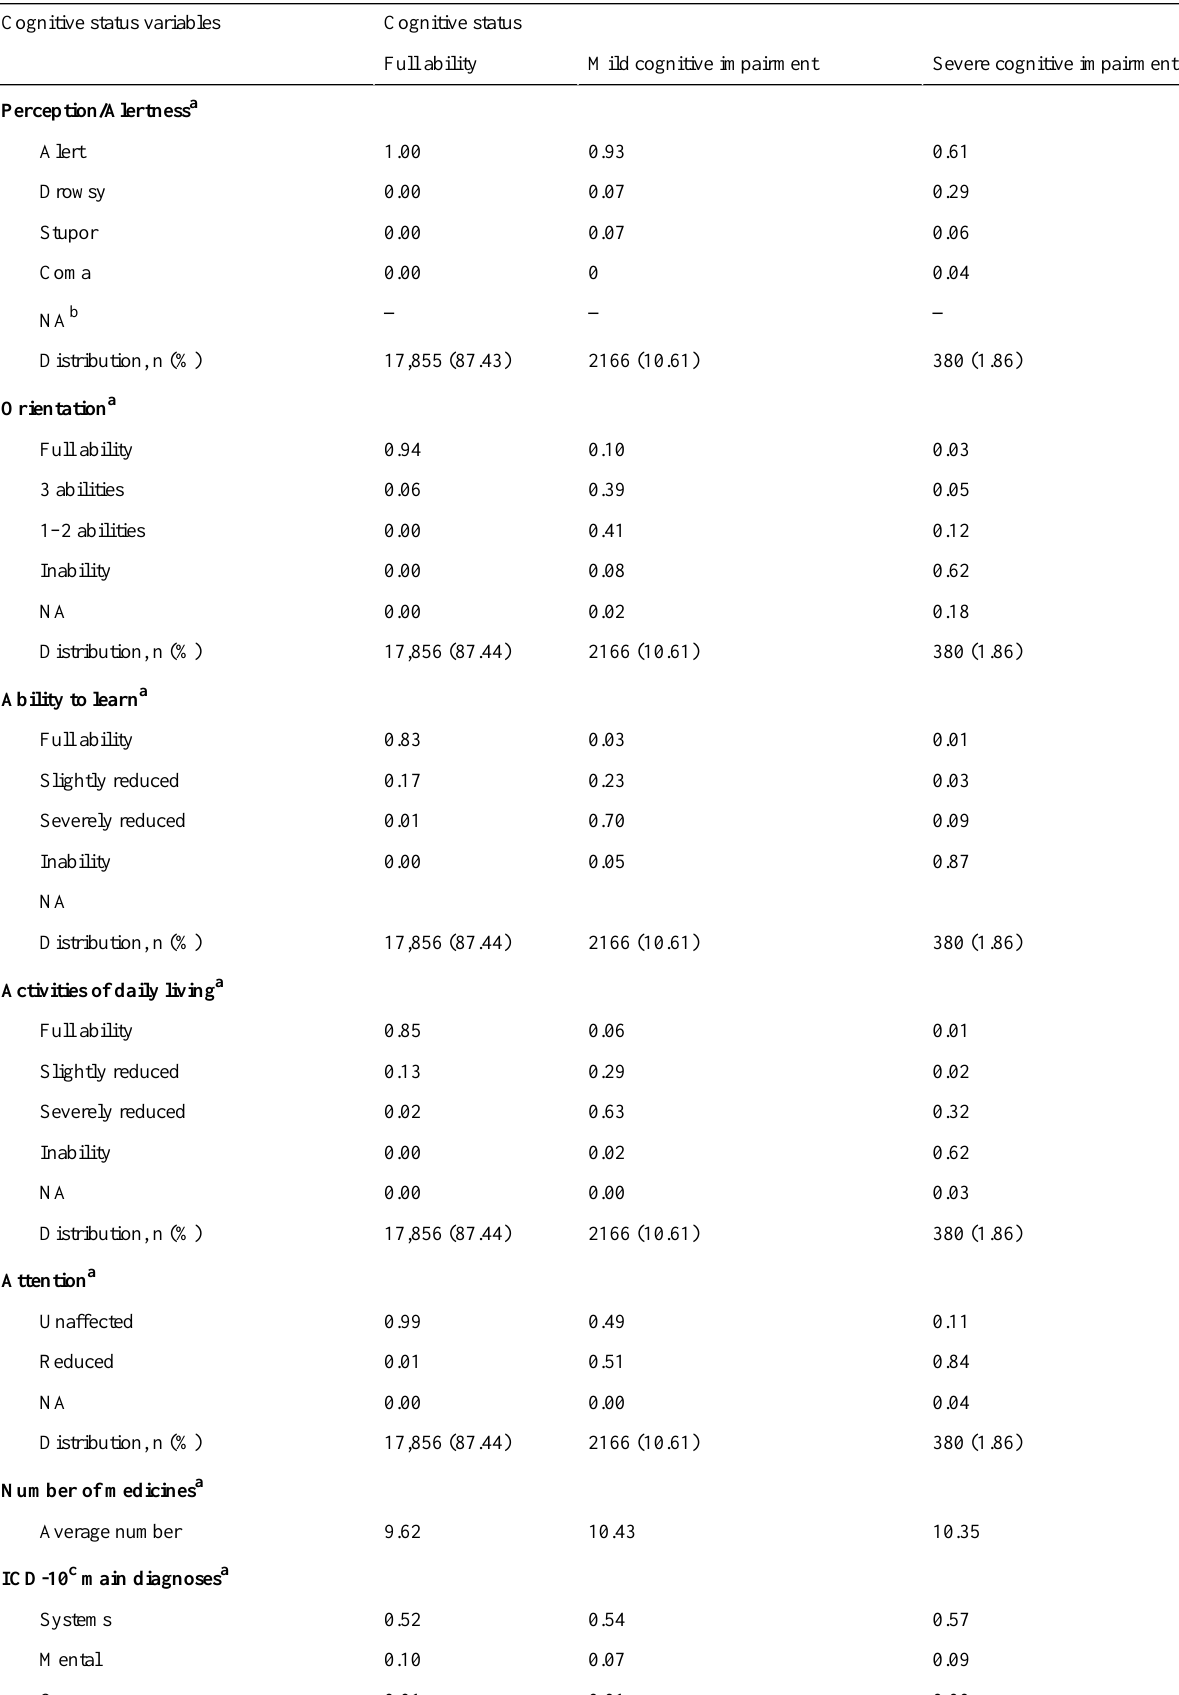
Table 2. Distribution of individuals in each group for all 5 cognitive status variables in the 3-cluster solution (N=20,422). Cognitive statusCognitive status